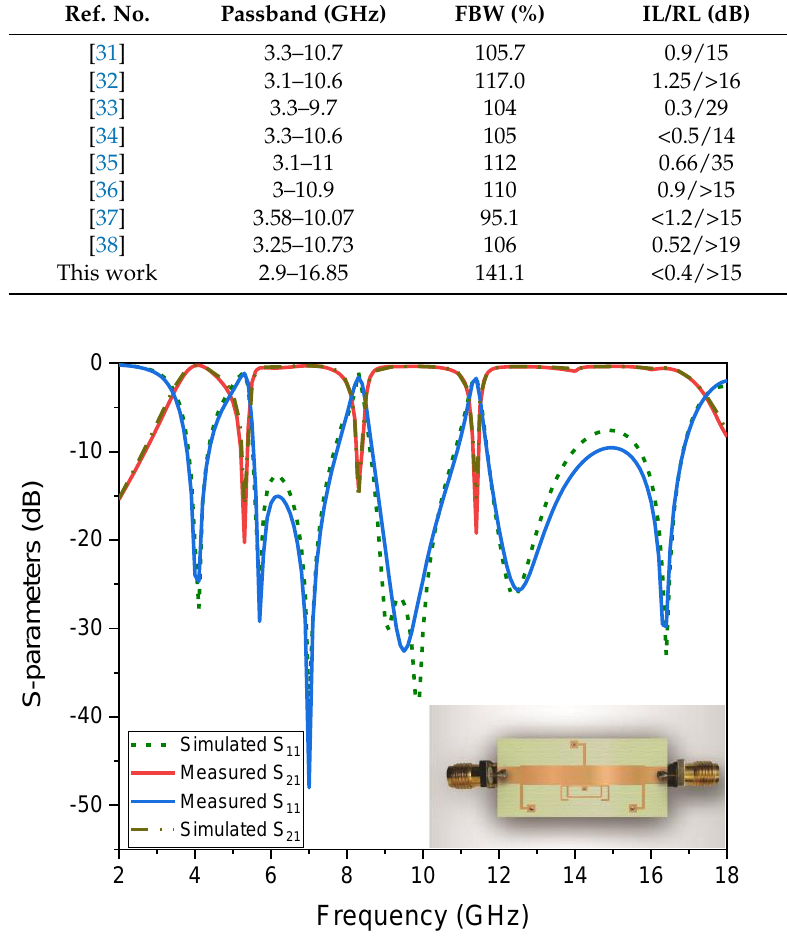
Figure 22. The measured and simulated results of the proposed triple-notched band filter .